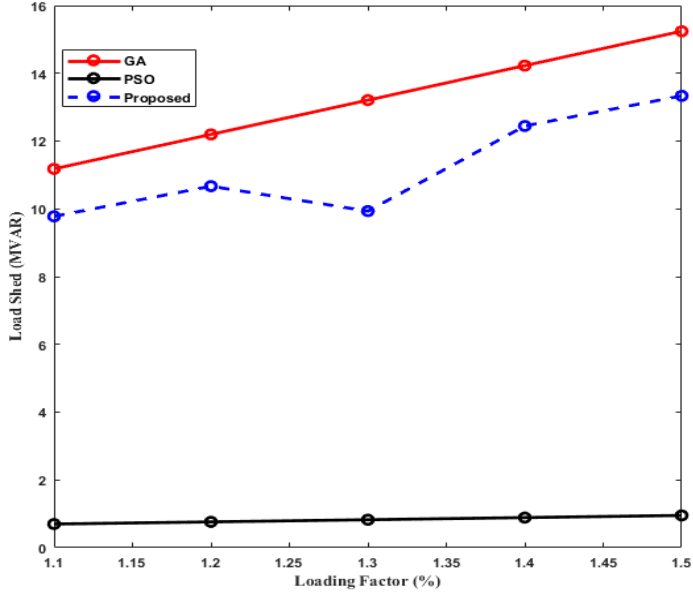
Figure 10. Total load shedding versus loading factor.